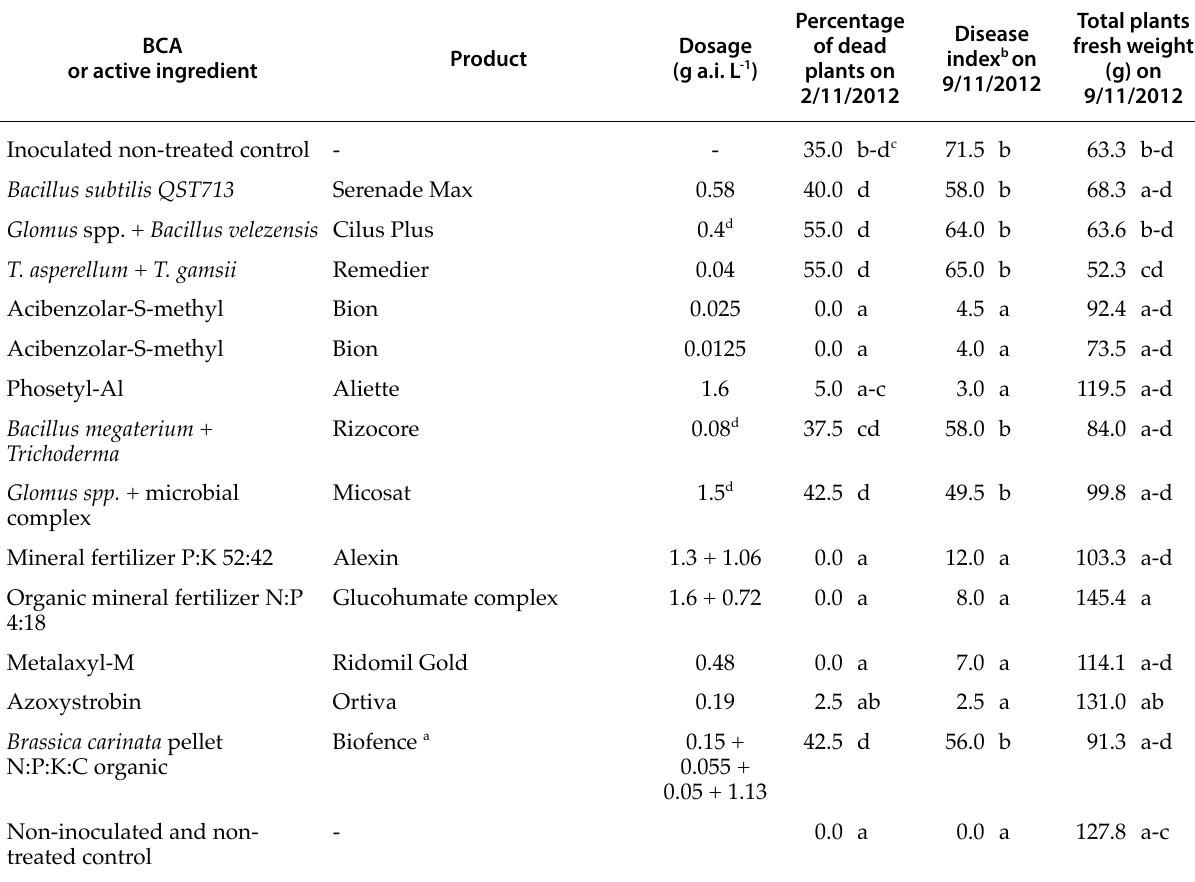
Table 7. Trial 5. Mean proportions of dead plants, mean disease indices (0‒100) and mean total plant fresh weights, for tomato plants receiving different